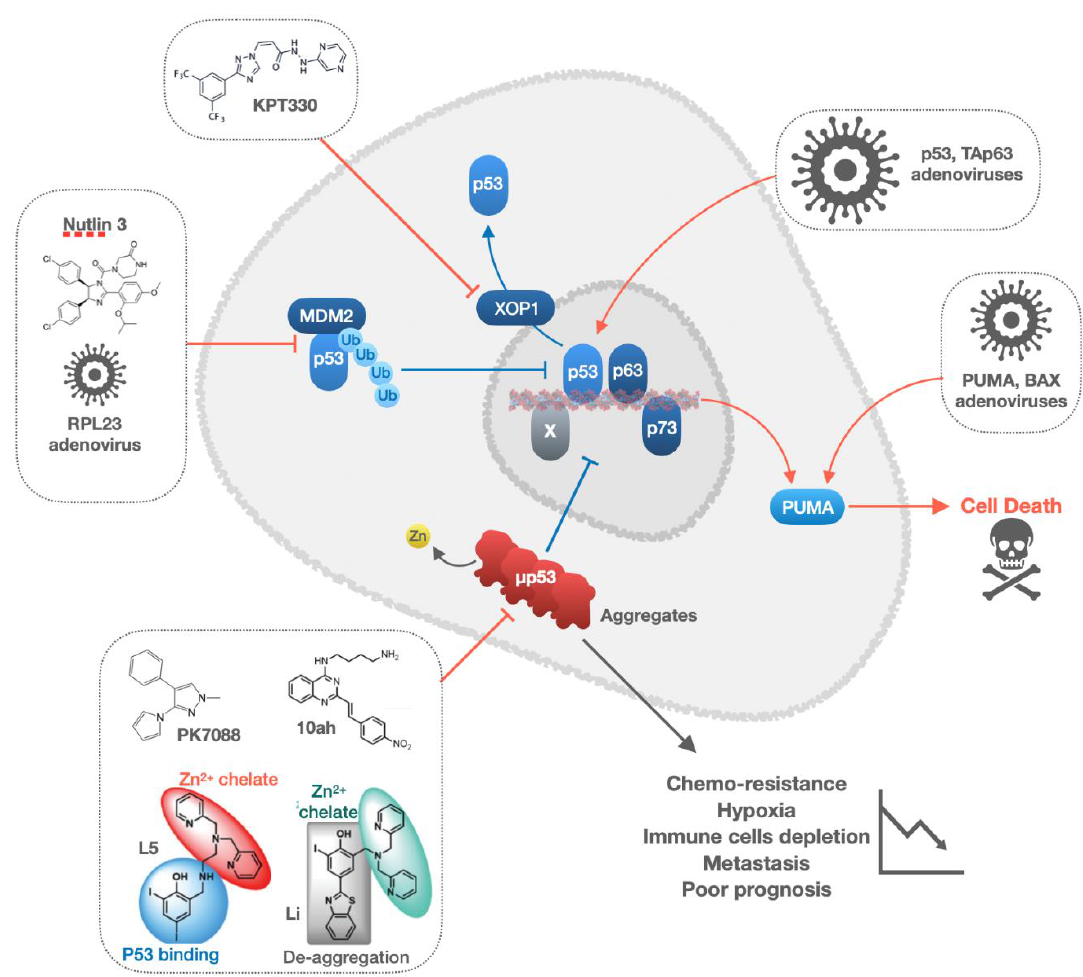
Figure 5. Therapeutic strategies targeting the p53 family that have been investigated in gastric